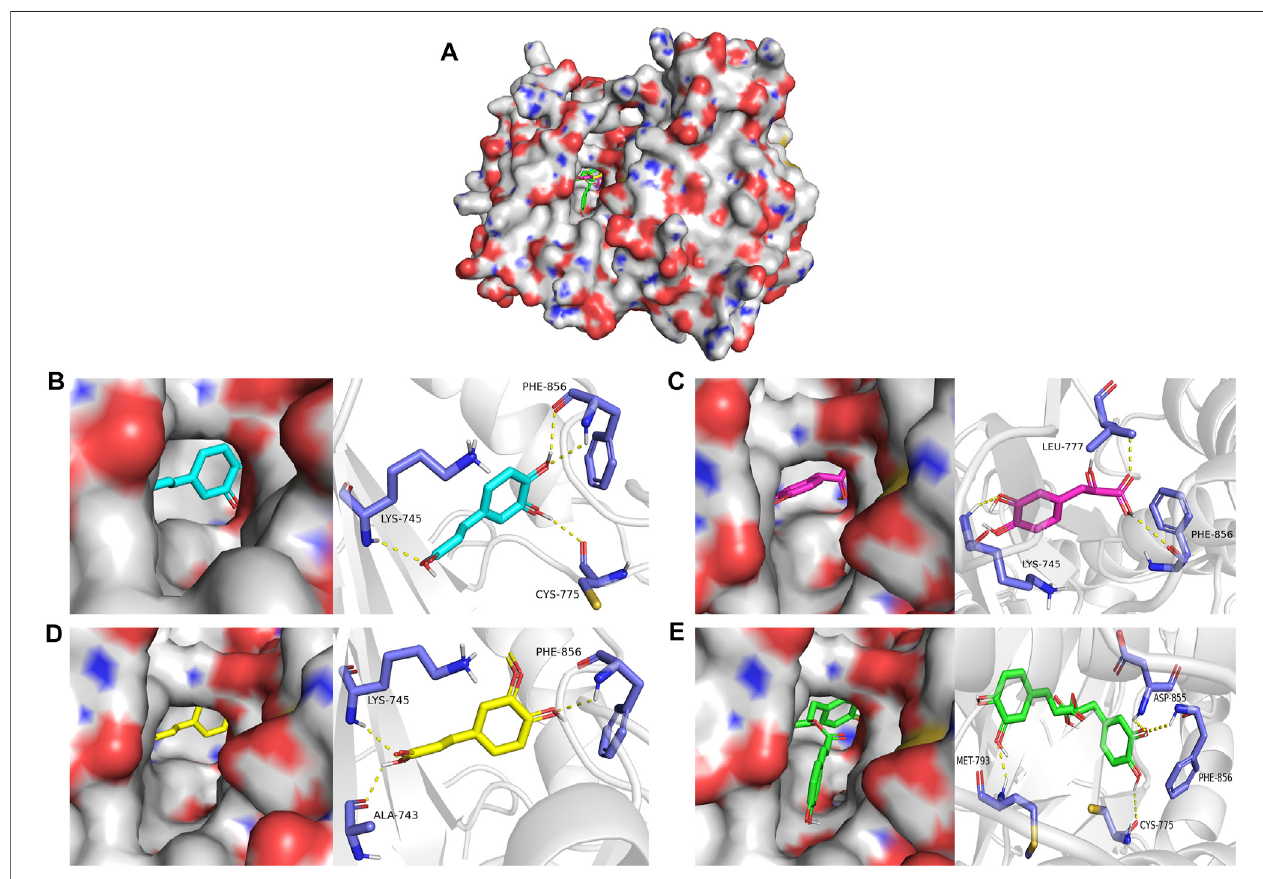
FIGURE6|(A) MoleculardockingoffourcompoundswithEGFR. (B) MoleculardockingofcaffeicacidwithEGFR. (C) MoleculardockingofdanshensuwithEGFR docking diagram. (D) Molecular docking of ferulic acid with EGFR. (E) Molecular docking of rosmarinic acid with